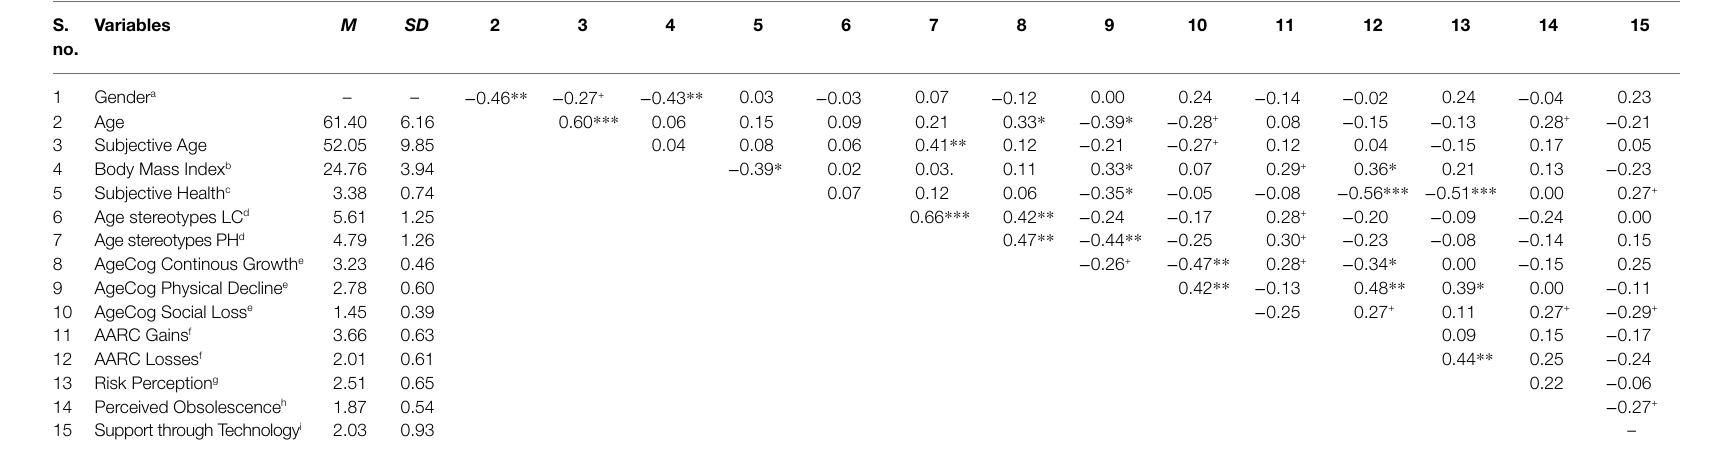
TABLE 1 | Descriptive statistics and intercorrelations of the study